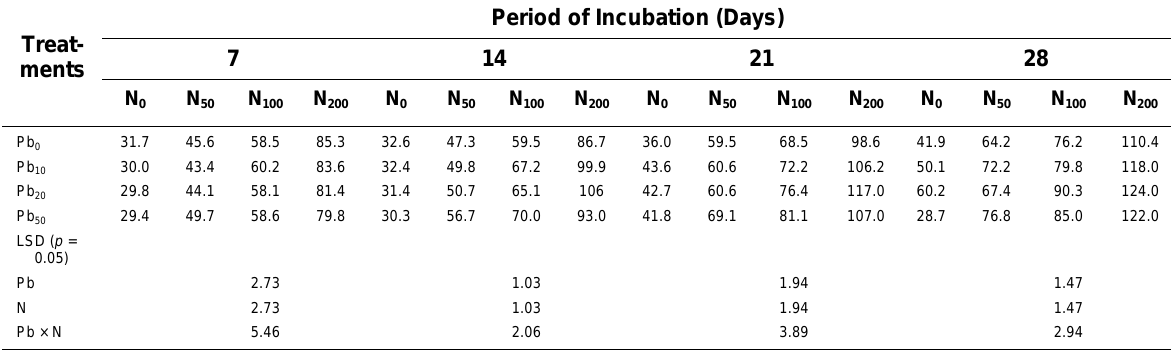
-N (mg kg –1 ) Content in Soil under 4 Saturated Condition Period of Incubation (Days)